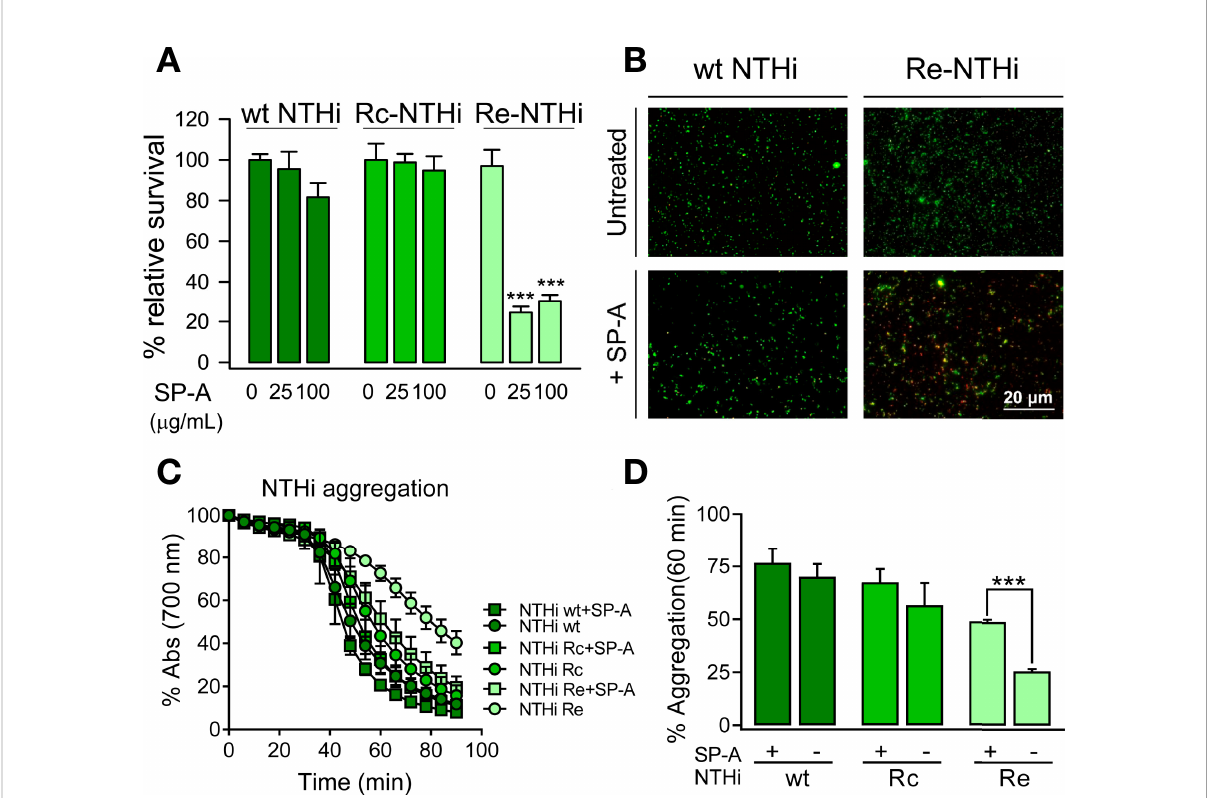
FIGURE 2 SP-A kills and induces aggregation of deep rough NTHi strains but not of NTHi strains expressing long-chain LOS. (A) Bacteria (10 5 CFUs/ml) were incubated with and without SP-A (25 and 100 µg/ml) and plated on sBHI agar for CFU count. The results are shown as % viable bacteria (percentage of live colony counts compared with untreated control). Data are means ± SD of three independent experiments with three biological replicates. (B) Bacterial killing was also visualized by fl uorescence microscopy using wt NTHi and Re-NTHi stained with CFSE. Bacteria were incubated with 100 µg/ml SP-A for 1 h and then stained with 30 m M propidium iodide to assess viability. Images shown are representative of three independent experiments. Scale bar, 20 m m. (C) SP-A-induced aggregation of NTHi strains was monitored by changes in absorbance at 700 nm during 1.30 h at 37°C without shaking in HBSS buffer. (D) Percentage of aggregation at 60 min is shown. Data are means ± SD (n=3, each triplicate). In (A, D) , results were statistically analyzed by one-way ANOVA followed by the Bonferroni multiple-comparison